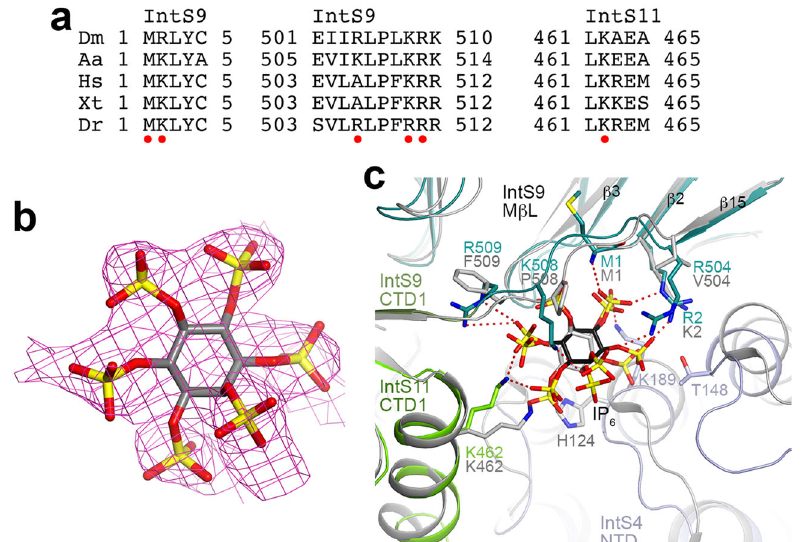
Fig. 5 | An IP 6 -binding site in human INTS4-INTS9-INTS11 complex (ICM). a Alignment of selected sequences for IntS9 and IntS11 residues in the IP 6 binding site. Residues that have ionic interactions with the phosphate groups on IP 6 are indicatedwiththereddots.Dm D.melanogaster ,Aa Aedesaegypti ,Hs H.sapiens, Xt Xenopus tropicalis , Dr Danio rerio . b Cryo-EM density for IP 6 in human ICM (EMDB 12159) 19 . An IP 6 molecule was built into the density and subjected to real-space